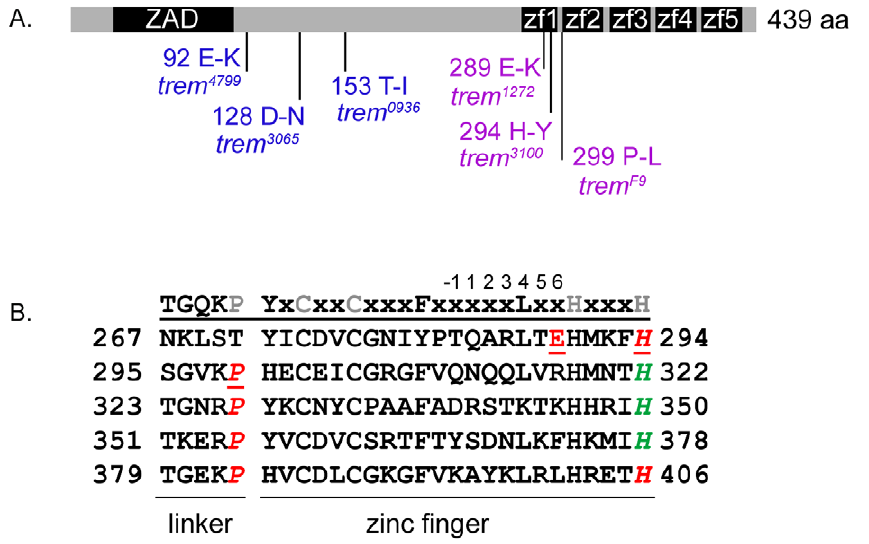
regions. Within two of these conserved blocks are two invariant cysteine pairs [18]. Crystallographic and biochemical studies of Grauzone have shown that the cysteines are important to coordinate zinc binding to stabilize a novel treble-clef-like structure [21].